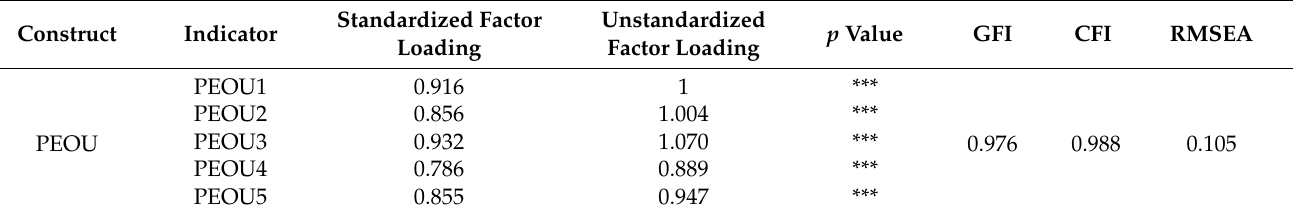
Table 1. TAM of perceived ease of